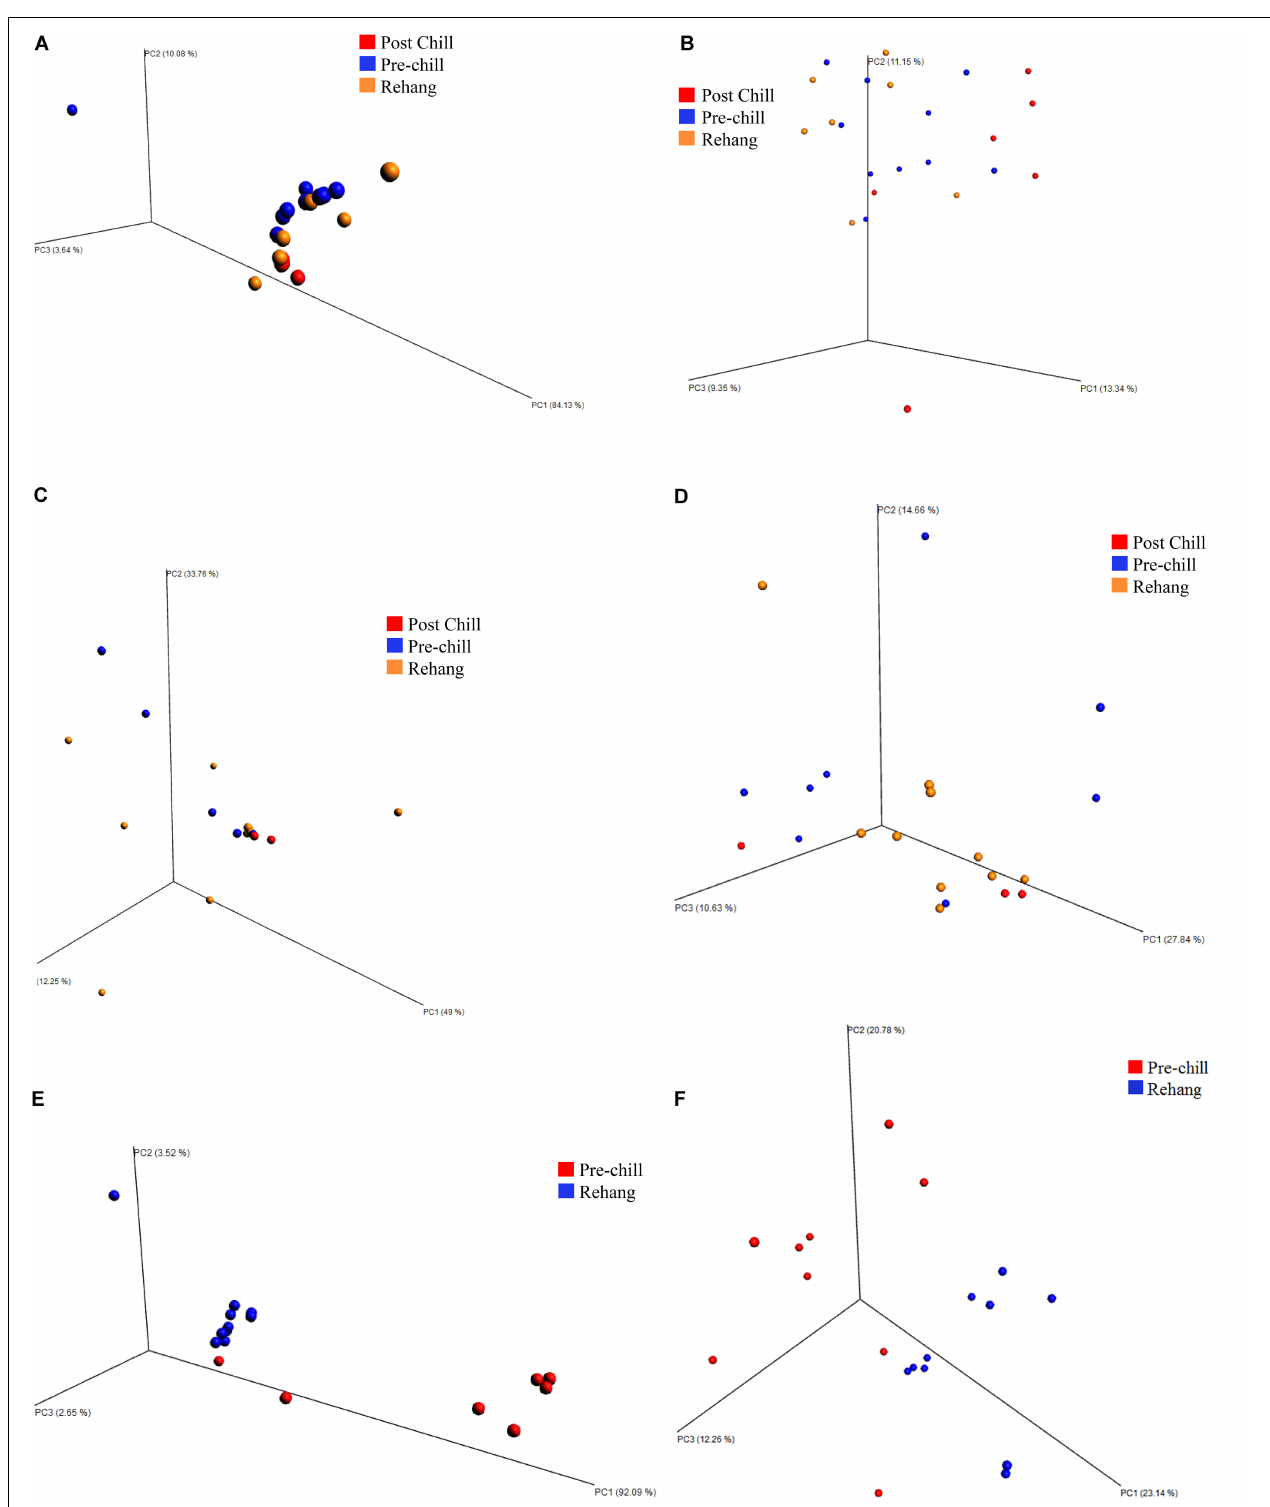
FIGURE 8 | Beta diversity among Pseudomonas spp. between sampling locations and individual processing abattoir. Weighted and unweighted UniFrac PCoA plots (A) Plant 1 weighted. (B) Plant 1 unweighted. (C) Plant 2 weighted. (D) Plant 2 unweighted. (E) Plant 3 weighted. (F) Plant 3 unweighted. Orange is for rehang, blue is for pre-chill, and red is for